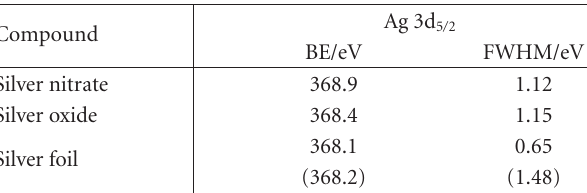
Table 2: Ag 3d 5 / 2 photoelectron peak positions and FWHM for standard silver compounds. Values in brackets are for the oxide layer detected on the silver